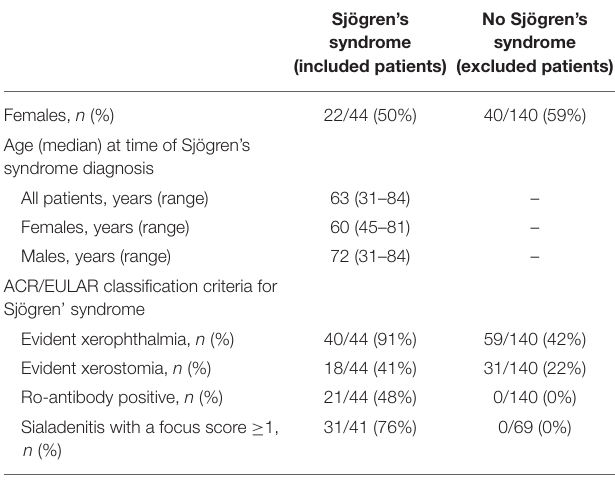
TABLE 1 | Baseline characteristics, ACR/EULAR classification criteria and patient history